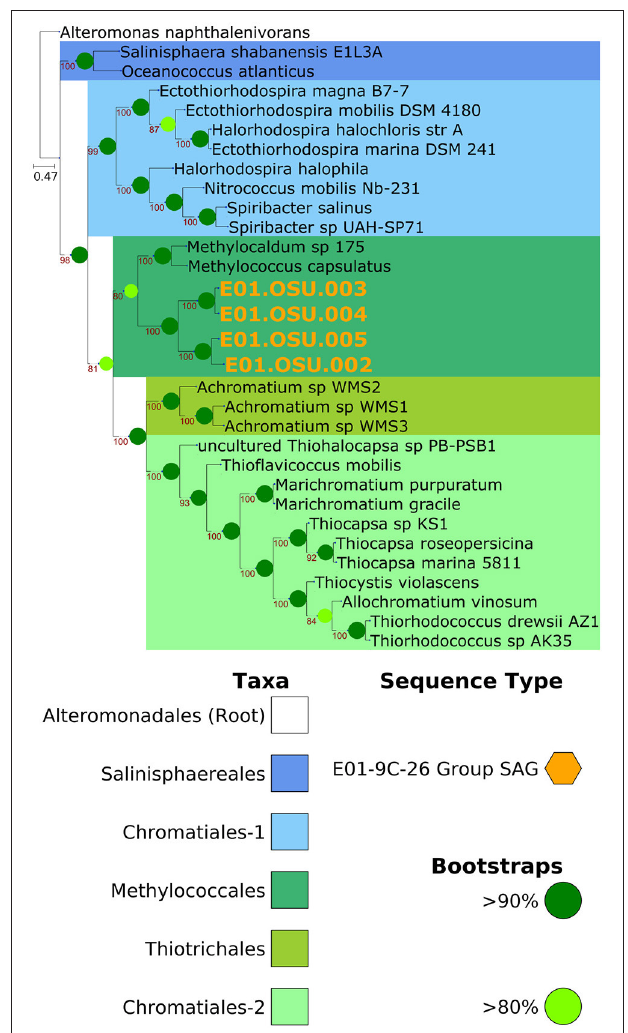
FIGURE 3 | Phylogenomic placement of E01-9C-26 within the Gammaproteobacteria. Placement of the E01-9C-26 clade SAGs indicates it that it is a related group to Methylococcus capsulatus . Consistent with this placement, many genes for methylotrophy were observed in the genomes. Tree is based on 142 single-copy conserved protein sequences and 32,829 amino acid residues, with up to 20% missing data allowed.